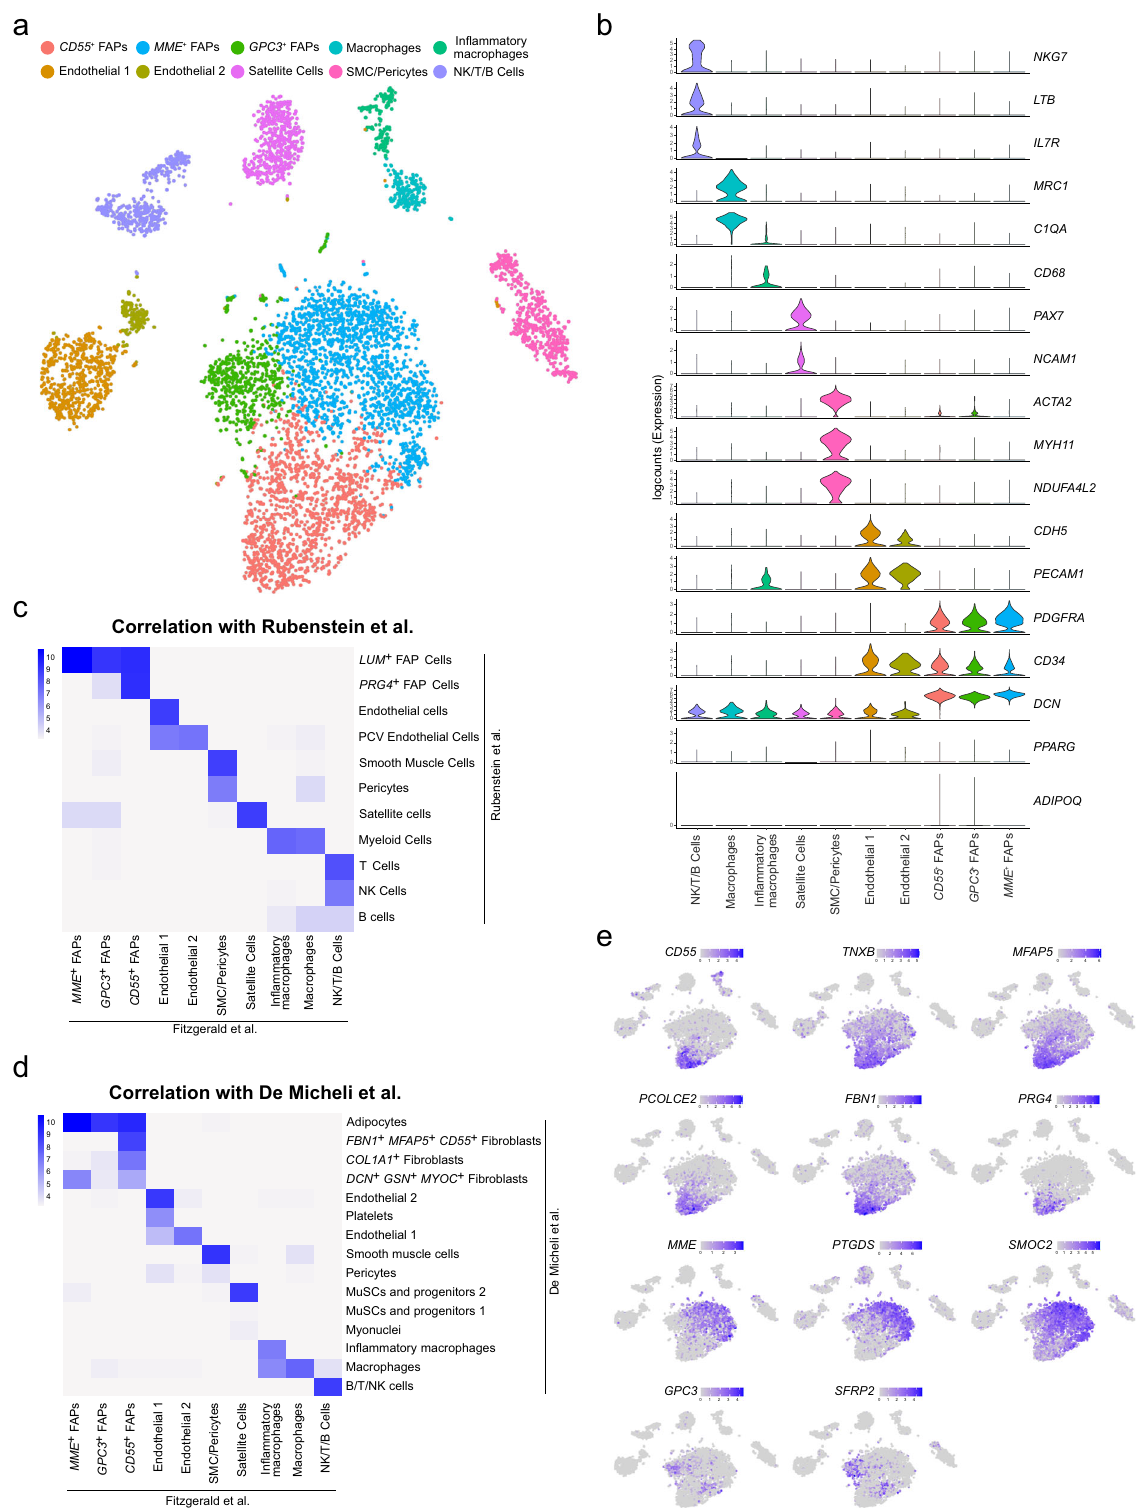
Fig. 2 scRNA-seq analysis from human muscle identi fi es main FAP and mononuclear cell populations. a TSNE plot of main cell types from human muscle, color-coded by the identi fi ed subpopulations. b Violin plots of logcounts values from well-known marker genes in each cell type, color-coded by the identi fi ed subpopulations. c , d Heatmap of the distribution of cells across Rubenstein et al. ( c ) and De Micheli et al. ( d ) labels ( Y -axis) and the original clustering of the muscle scRNA-seq dataset ( X -axis). Color scales represent the log 10 -number of cells for each label-cluster combination. e TSNE plots of expression levels of marker genes from the different FAPs subpopulations, color-coded by logcounts